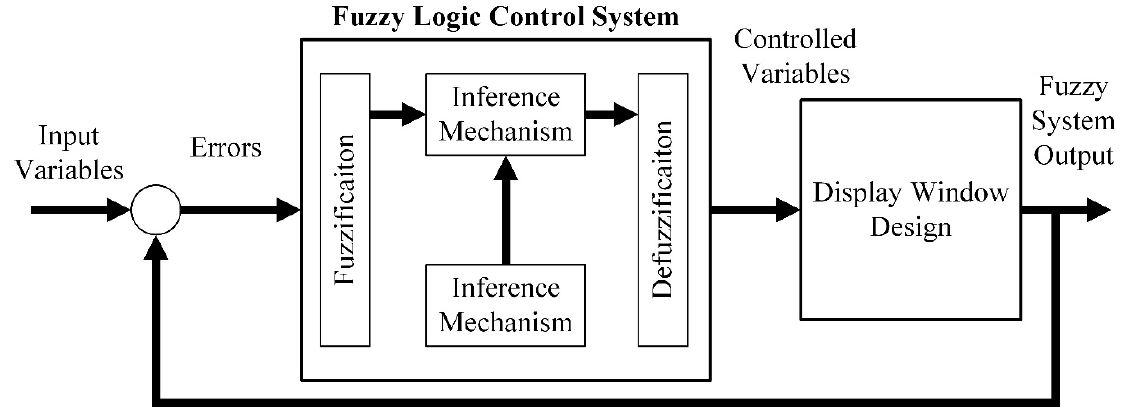
Figure 9. Structure of the fuzzy logic controller.